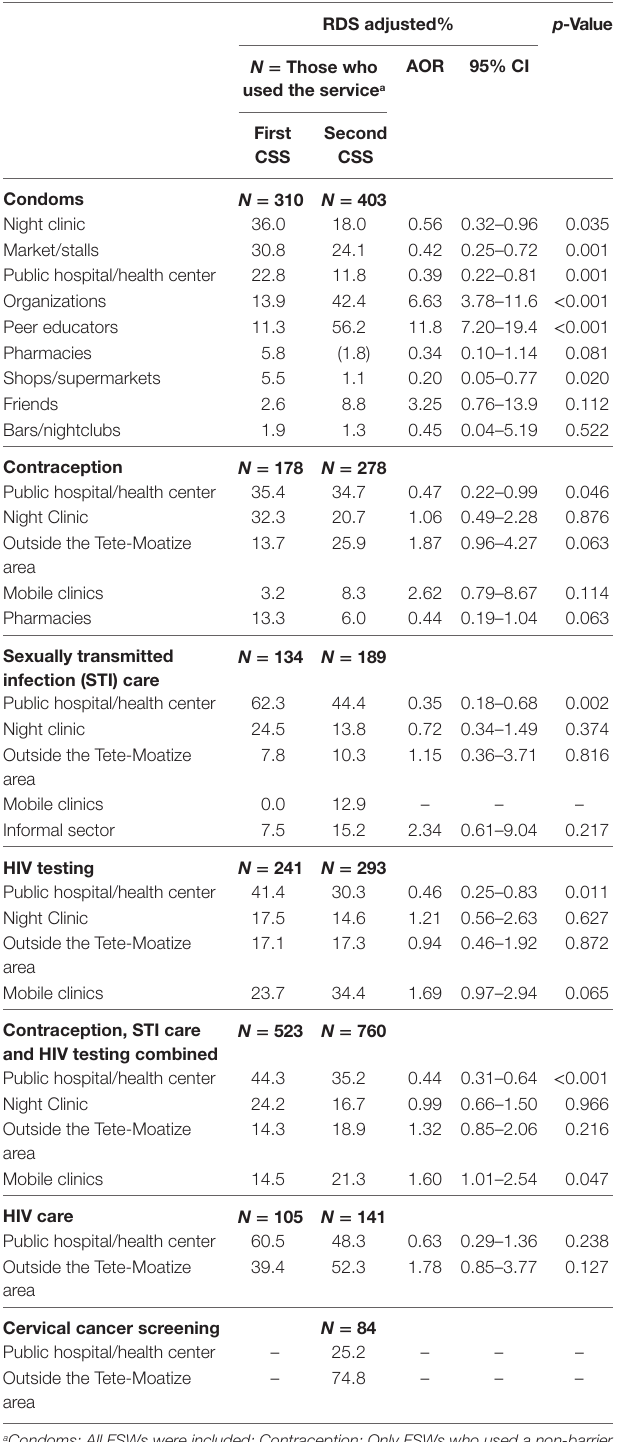
TaBle 5 | Where female sex workers (FSWs) obtained sexual and reproductive health (SRH) commodities and services. rDs adjusted% p -Value N = Those who used the service a